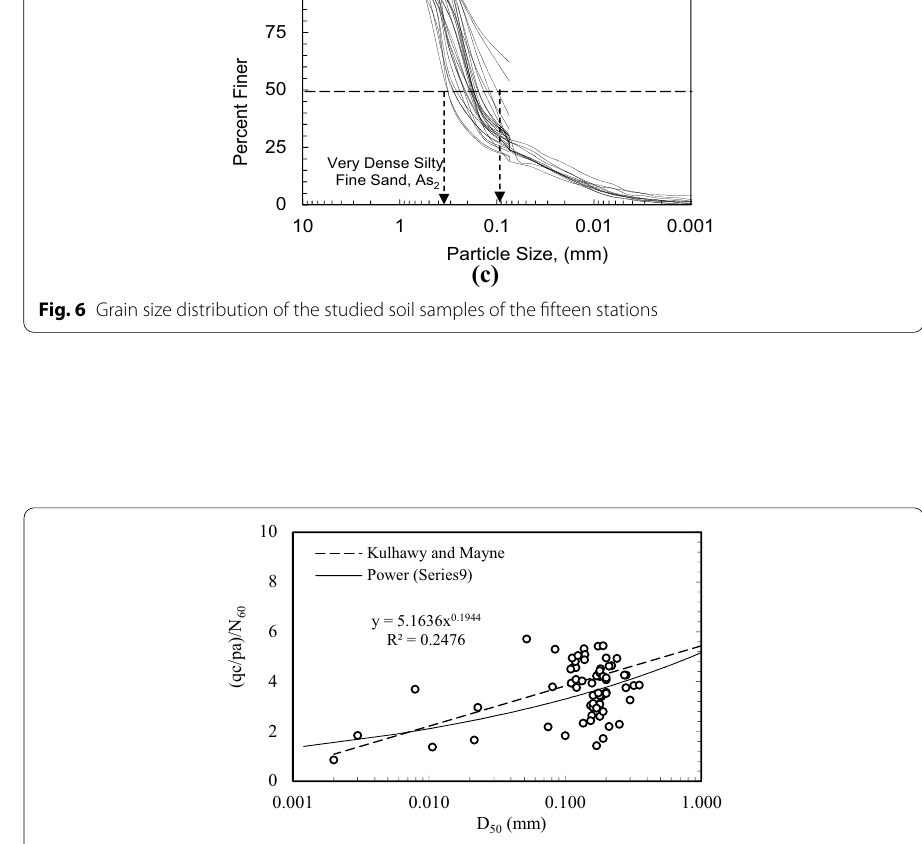
Fig. 7 Correlation between (q c /p a )/N 60 and D